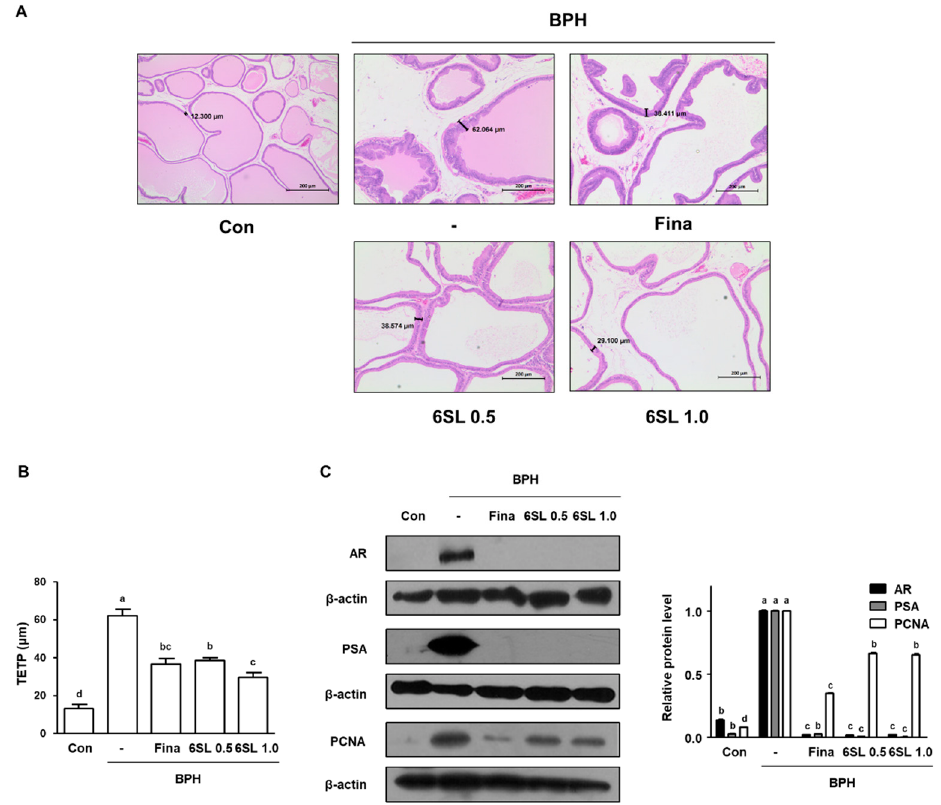
Figure 2. Effect of 6SL on histological change and androgen-relative protein expression in TP-induced BPH rat model. ( A ) Prostatic tissue slides were stained by hematoxylin and eosin (H&E) and observed (magnification × 100). ( B ) Thickness of epithelium tissue from prostate (TETP) was measured and expressed as the mean ± SD of five rats per experimental group. ( C ) The protein expressions of androgen receptor (AR), prostate-specific antigen (PSA), and proliferating cell nuclear antigen (PCNA) in prostatic tissues were determined by immunoblotting. The densities of protein were calculated using ImageJ Software and the relative protein level was normalized to internal control β -actin. Values with di ff erent letters indicate significant di ff erences, p <